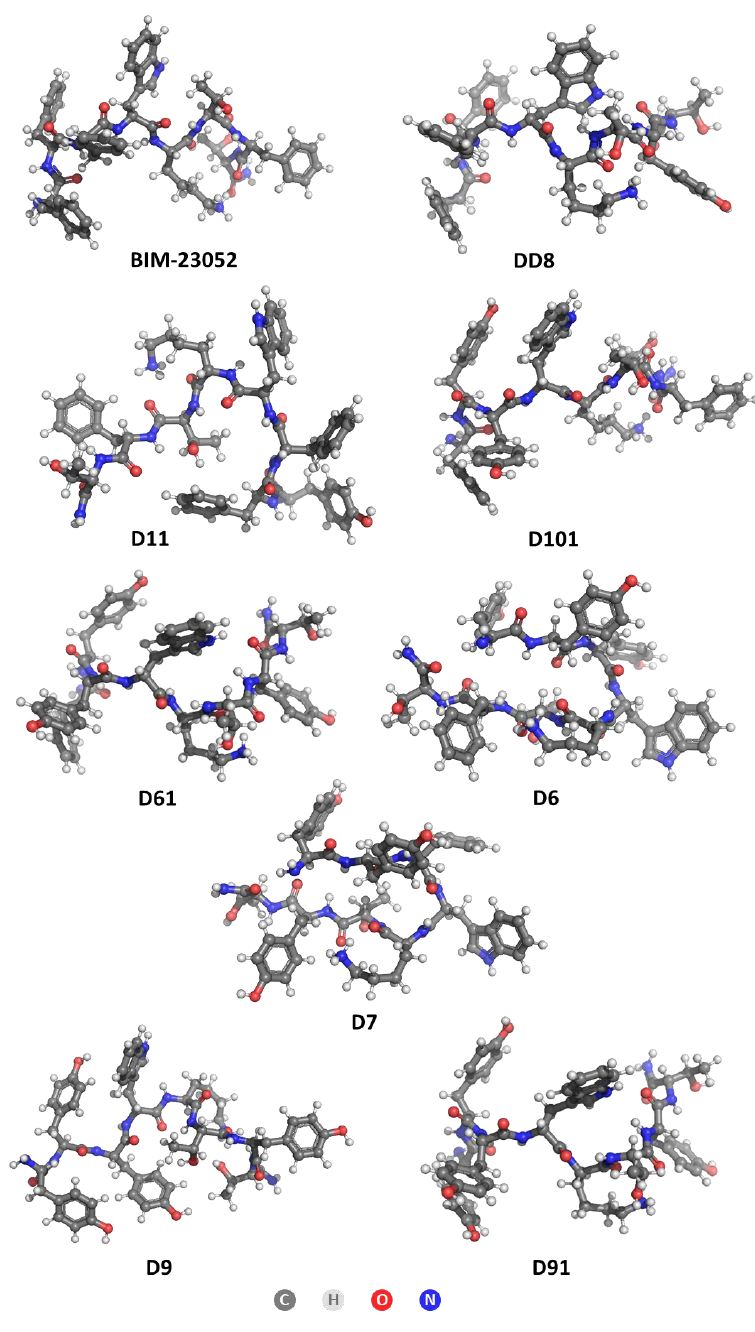
Figure 4. Optimized structures of BIM-23052 and its analogs. Table 5. LogP values of targeted structures.